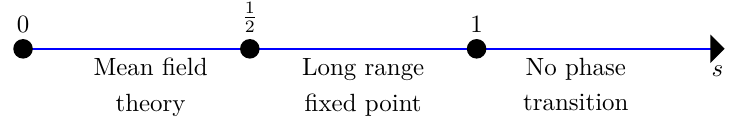
Figure 3 . Continuum models for various values of s .